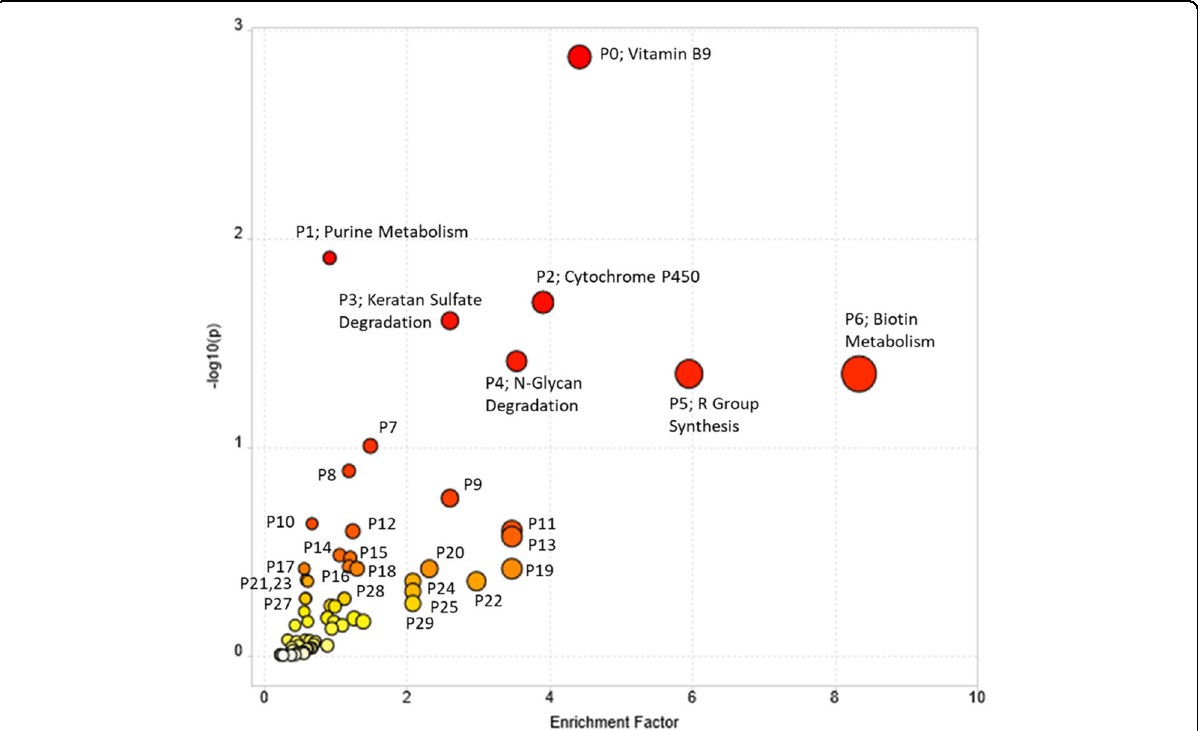
Fig. 2 The distribution plot of the Enrichment Factor versus − log10(P) of the pathway enrichment analysis. Mummichog was used to evaluate the pathway enrichment of all features ( m / z ) with p < 0.01 based on the t -test for the comparison of high opium users who were diagnosed as OUD positive versus high opium users who were diagnosed OUD as negative was used as the threshold to determine the size of the permutation groups used by the